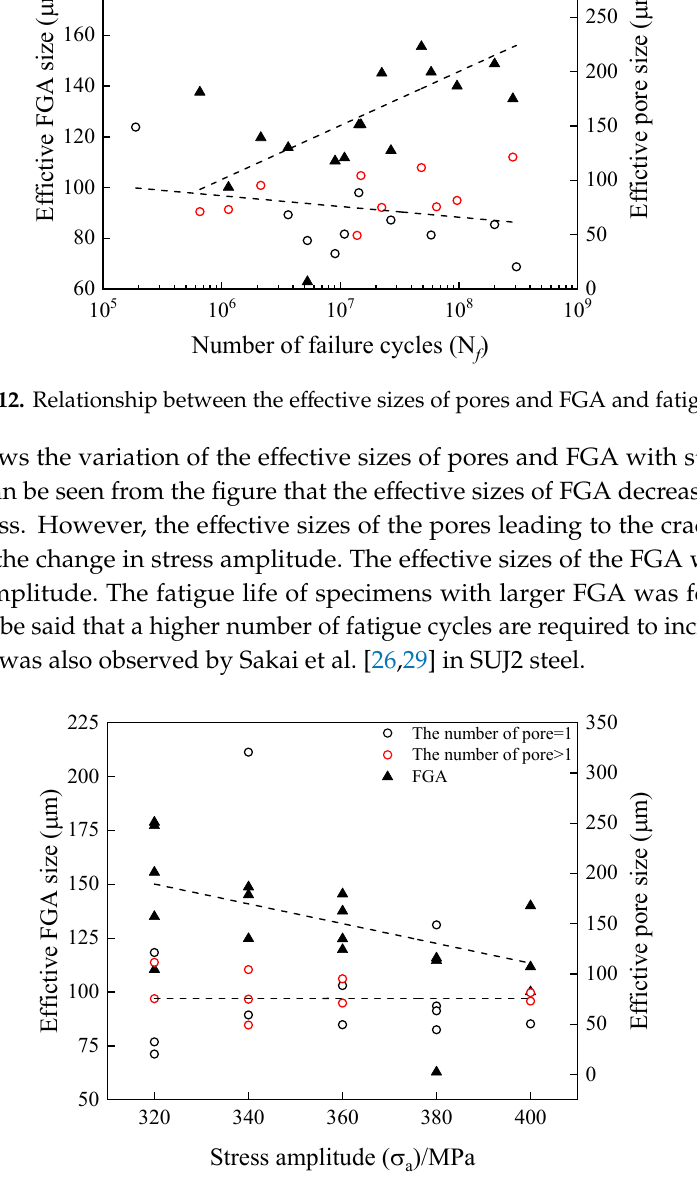
ff ective sizes of the pores and FGA and stress Figure 13. Relationship between the effective sizes of the pores and FGA and stress amplitudes. Figure 13. Relationship between the e